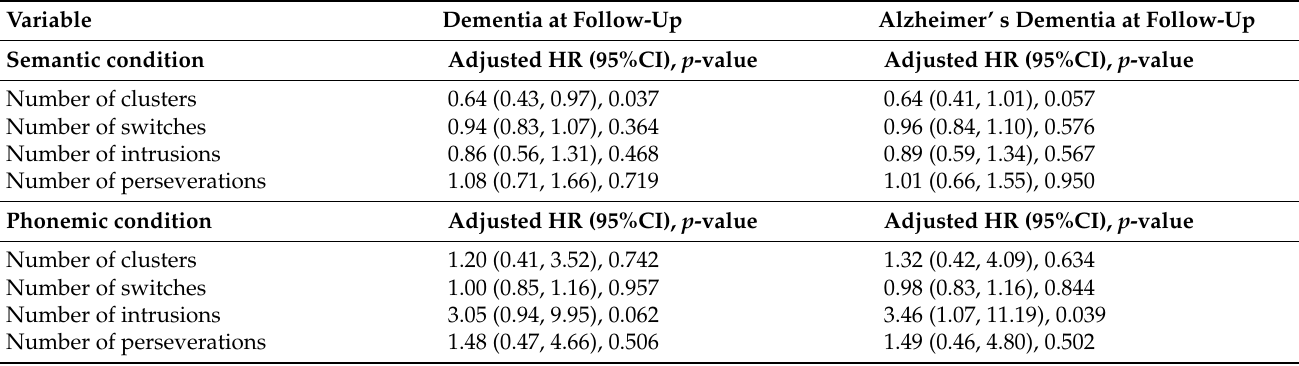
Figure 1. Survival curves for incident dementia according to the perseverations on the semantic task. Owing to their small number, individuals with ≥ 3 perseverations were clustered together ( n = 40). Table 4 summarizes the associations of the qualitative VF parameters with incident to the hazard of future dementia or AD. Similarly, no qualitative parameter was linked to the risk of CN individuals progressing to MCI (Table 5). Table 4. Associations between qualitative verbal fluency indices and incident all-cause dementia (primary outcome) and Alzheimer’s dementia (secondary outcome).